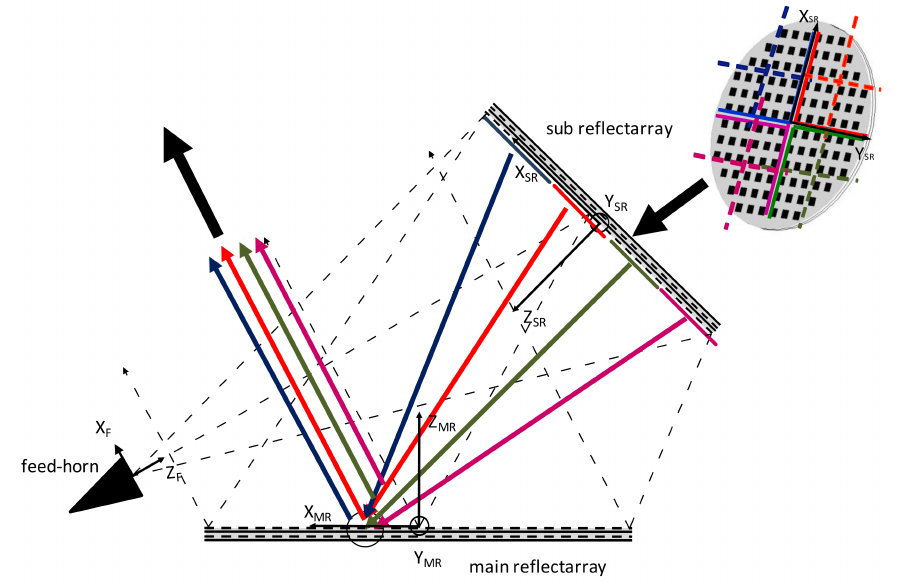
Figure 1. Scheme of the dual-reflectarray designed antenna with the sub-reflectarray divided in groups of